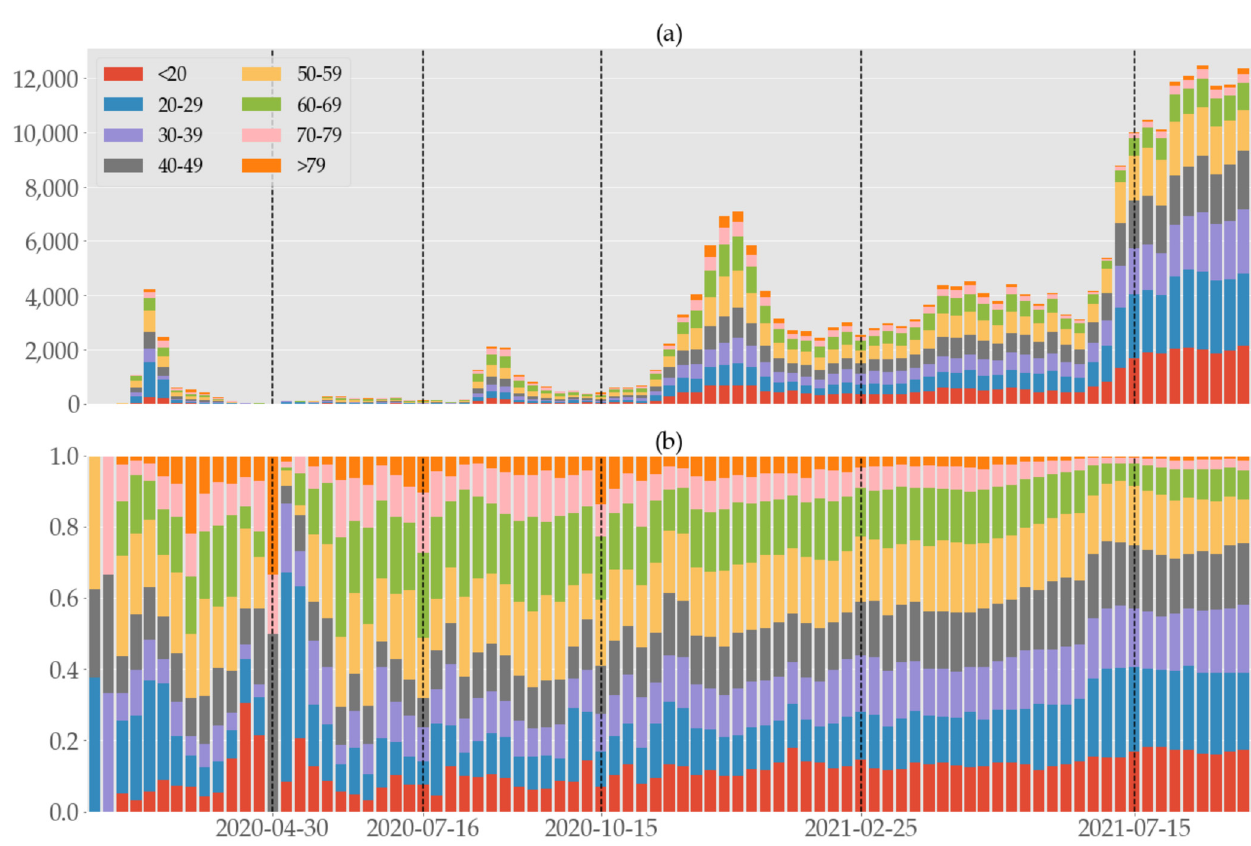
Figure 6. Weekly ( a ) numbers and ( b ) rates of confirmed COVID-19 cases segmented according to age brackets in South Korea from 19 January 2020 to 16 September 2021, divided into six periods by the vertical dashed